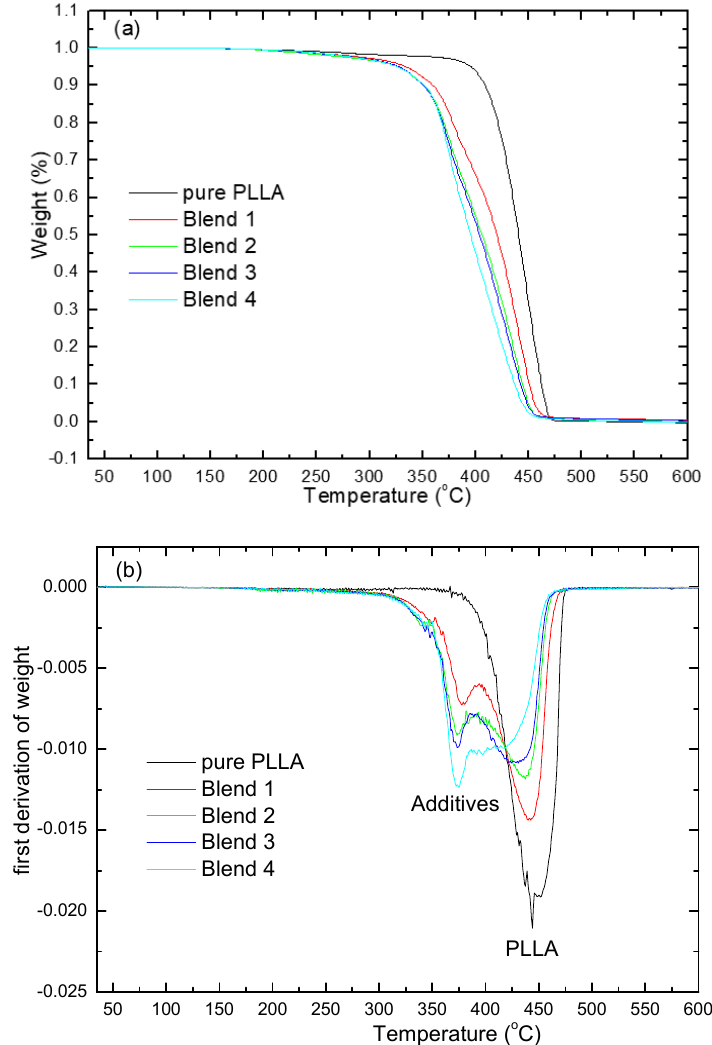
Figure 4. Thermogravimetric analysis of pure PLLA and its blends: ( a ) thermogravimetric curves and ( b ) derivative thermogravimetric curves.